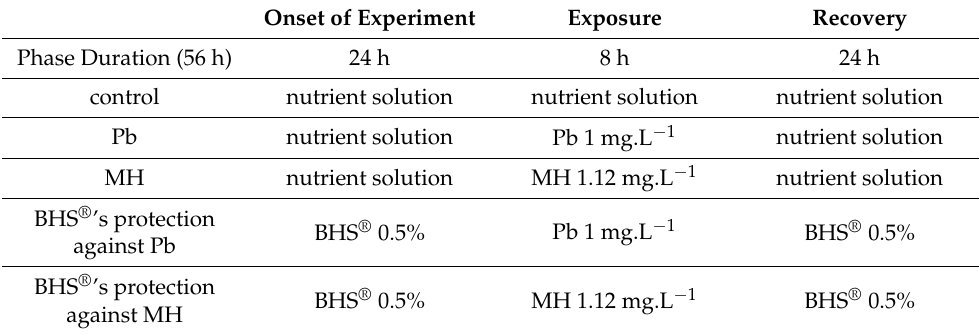
Table 2. Experimental set-up to test protective effects of BHS ® against a metallic (lead) and an organic (maleic hydrazide) molecule.